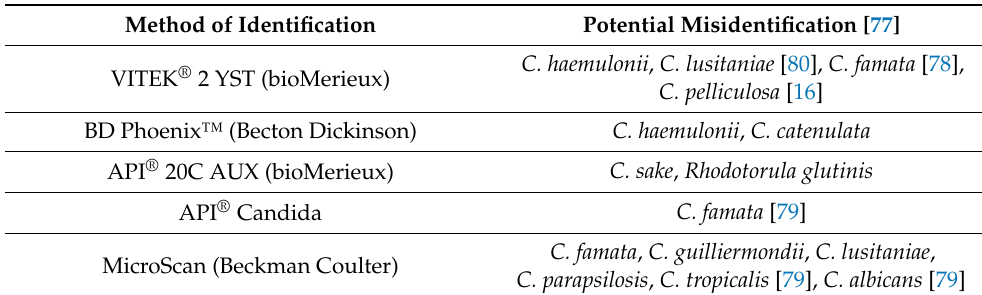
Table 1. Biochemical platforms that may misidentify C. auris .